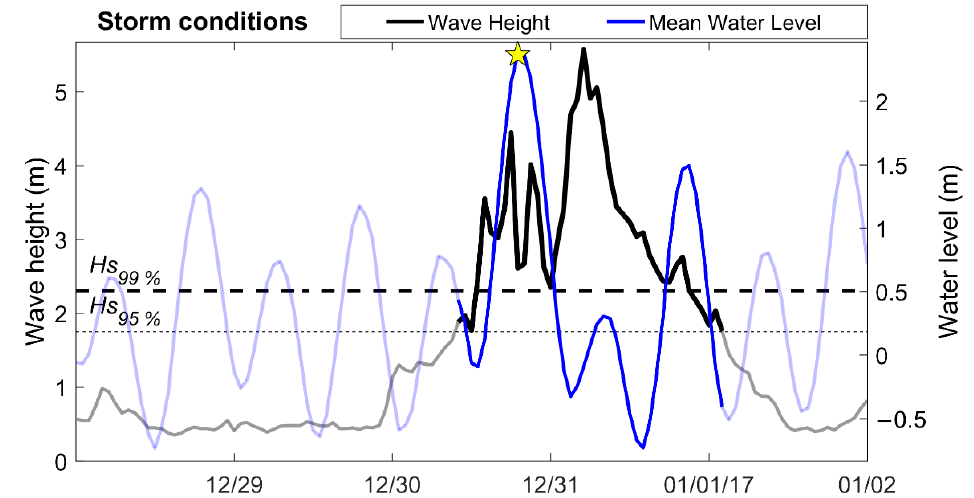
Figure 25. In situ hydrodynamic conditions observed during the 30 December 2016 at the AWAC mooring. The significant wave height time series is displayed in gray (black during the storm), the water level fluctuation is in blue. The highest water level during the storm is highlighted by a yellow star. The 99th and 95th percentiles of significant wave height are shown (dashed lines).